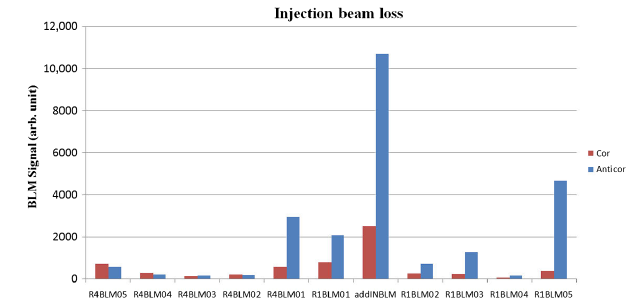
FIG. 12. The measured beam loss for the correlated and anticorrelated painting during the